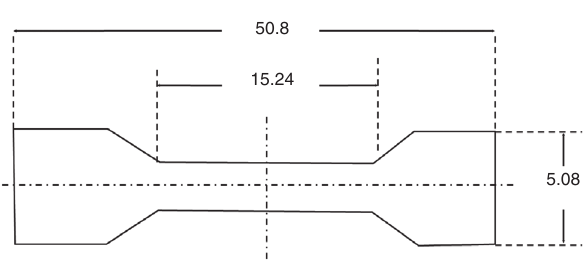
Figure 2 Schematic size of tensile test specimen (in mm).